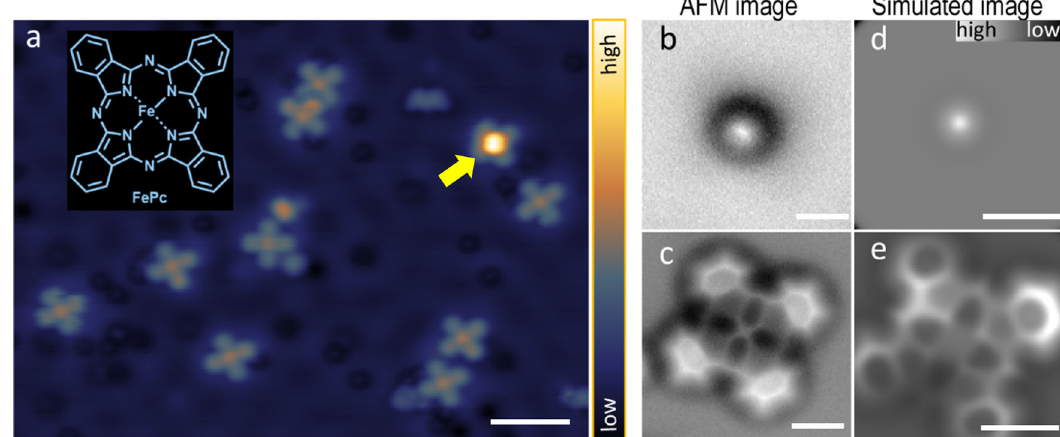
Fig. 1 STM and AFM images of FePc and the datively bonded CO-FePc complex. a STM image of the FePc molecule with (indicated by the arrow) and without adsorption of CO, with the insert showing the chemical structure of FePc (set point: V sample = + 100 mV, I = 100 pA, scale bar: 3 nm). b, c Experimental AFM images of FePc with and without adsorbed CO, obtained using a CO-terminated tip ( V = 0 V, A = 100 pm, scale bar: 0.5 nm) at tip heights z of + 160 pm and -10 pm, respectively. The tip height z was set with respect to a reference height given by the STM set point (100 mV, 100 pA) above the bare Cu(111) substrate in the vicinity of the molecule. The minus sign of tip height z indicates a decrease of tip height. d, e Simulated AFM images corresponding to CO-FePc and FePc at tip heights of 554 pm and 300 pm. The tip height in the simulation is de fi ned as the distance between the front atom of the tip and the average height of the FePc complex (excluding the decorated CO) (scale bar: 0.5